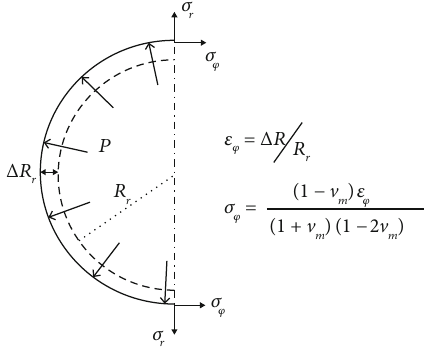
Figure 3: Theoretical and fi nite element analysis (FEA) results of the normalized force F / F 0 vs. normalized displacement relationship in di ff erent geometric parameters ( G , t , d , R 1 , R 2 , n , and δ R 2 − 1 Þ